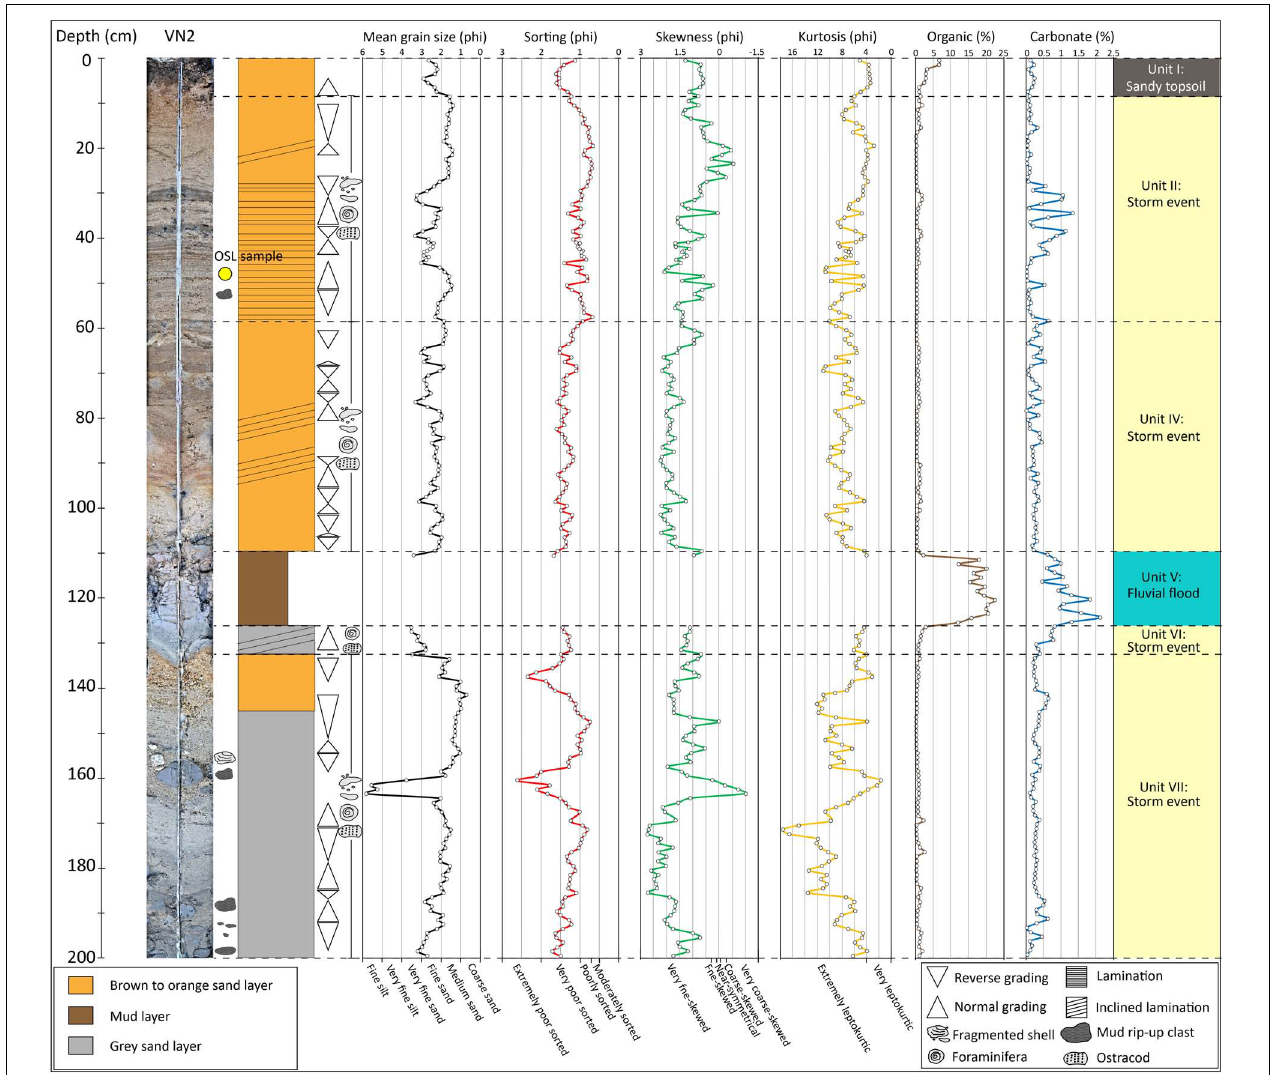
FIGURE 5 | Stratigraphy of core VN2 with vertically plotted grain size parameters (mean, sorting, skewness, and kurtosis) and LOI (organic and carbonate contents) showing the unit of the storm and FF layers. Storm layers in Units II, IV, VI, and VII mostly exhibited the set of normal and reverse grading with relatively low organic and carbonate contents, whereas Unit V was interpreted as the FF layer and showed high organic and carbonate contents at a 110–127-cm depth.